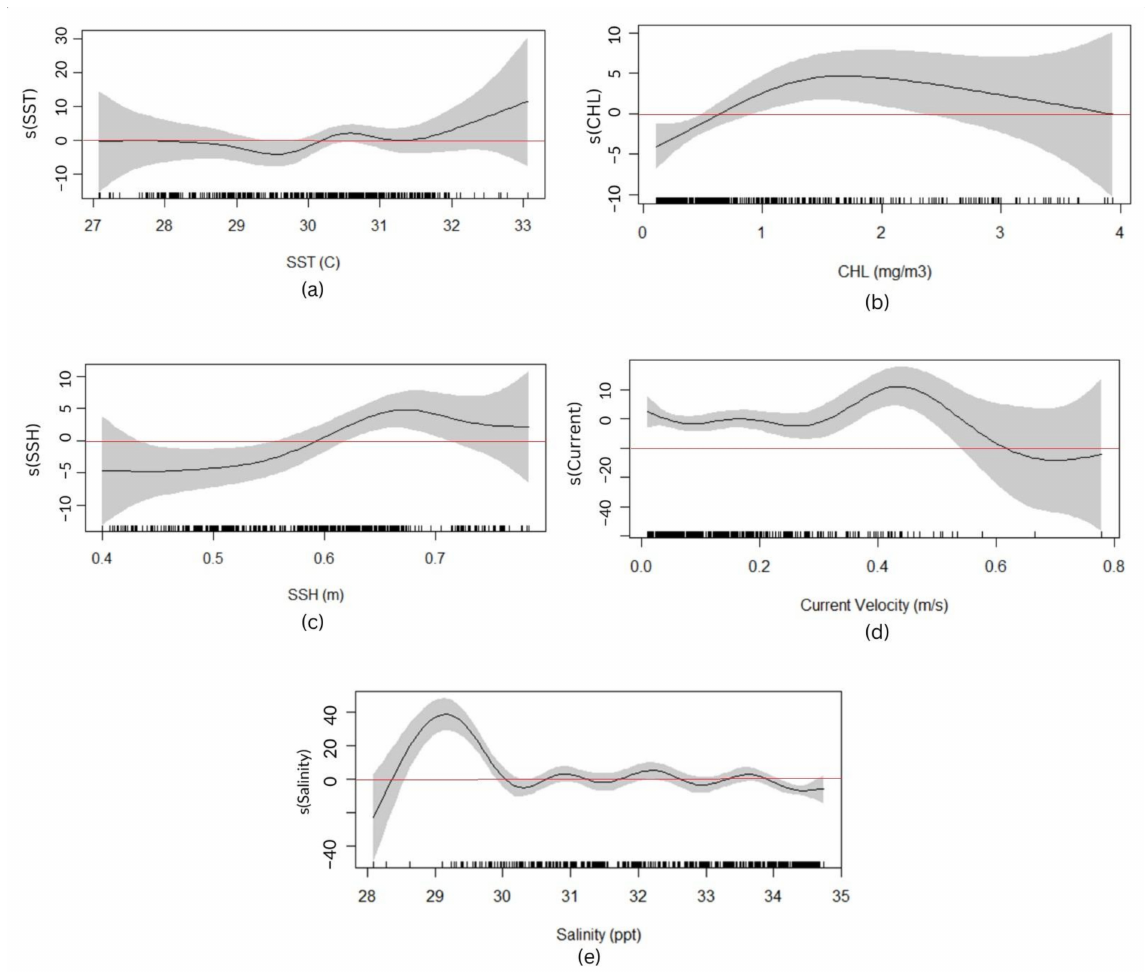
Figure 9. GAM-derived effect of the five oceanographic variables on CPUE, from the model con- structed with: ( a ) SST, ( b ) Chlorophyll- a , ( c ) Current Velocity, ( d ) SSH, and ( e ) Salinity. The grey- shaded area indicates the 95% confidence intervals; the solid line shows the fitted GAM function, which describes a predictor variable’s effect on the response variable (CPUE). The rug plot on the x-axis shows the relative density of data points. Values of a predictor variable indicating a positive effect on CPUE were read as all values for which the fitted GAM function was above the zero axis (red